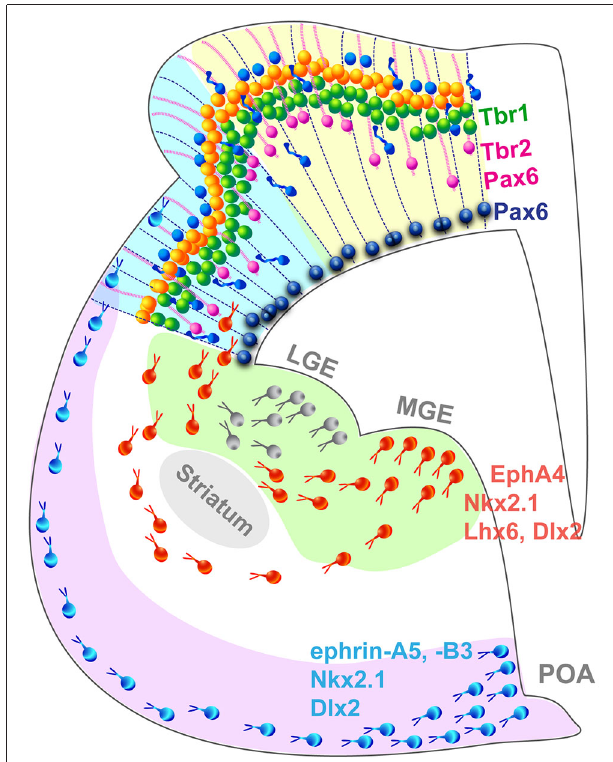
FIGURE 2 | Summary schematic representing the principal cell populations and mechanisms involved in the formation of a complex gyrated neocortex . Pax6+ radial glia cells (blue) are attached to the ventricular surface and extend parallel processes to the pial surface of the cortex. In higher mammals, an additional population of Pax6+/Tbr2+ progenitors (pink) attached exclusively to the pial surface contribute to the radial expansion of the neocortex including the formation of folds. Newborn neurons migrate radially in an inside-out pattern. Interneurons migrate tangentially from subcortical origins along a superficial and a deep migratory stream, guided by a combination of attracting and repulsive cues. LGE , lateral ganglionic eminence; MGE , medial ganglionic eminence; POA , preoptic